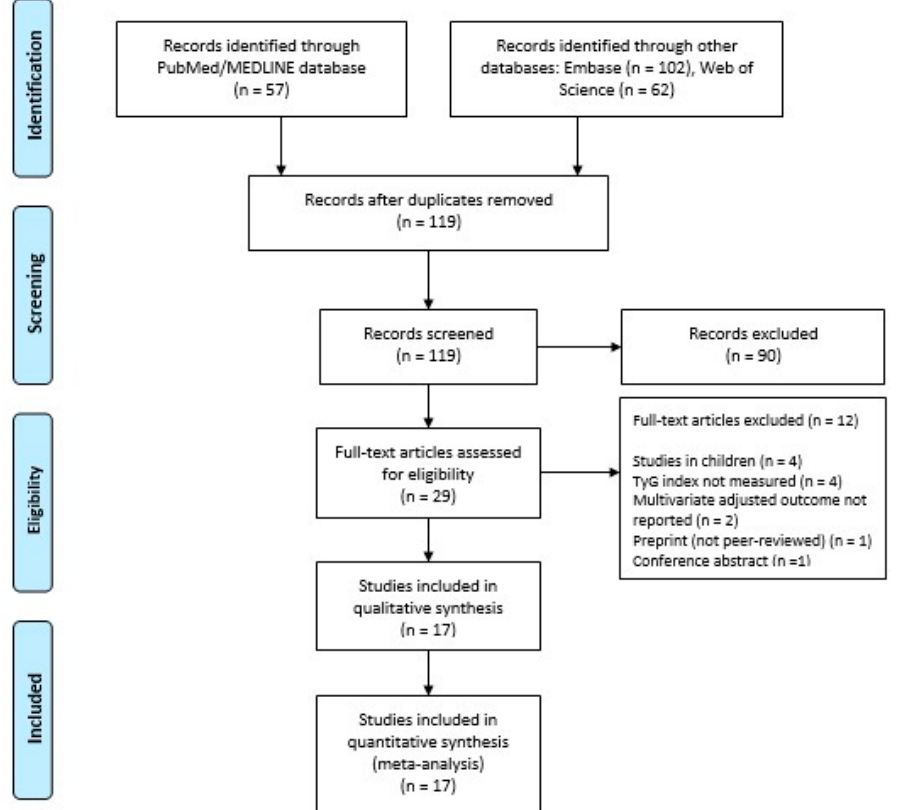
Figure 1. PRISMA flow diagram for the selection of studies.